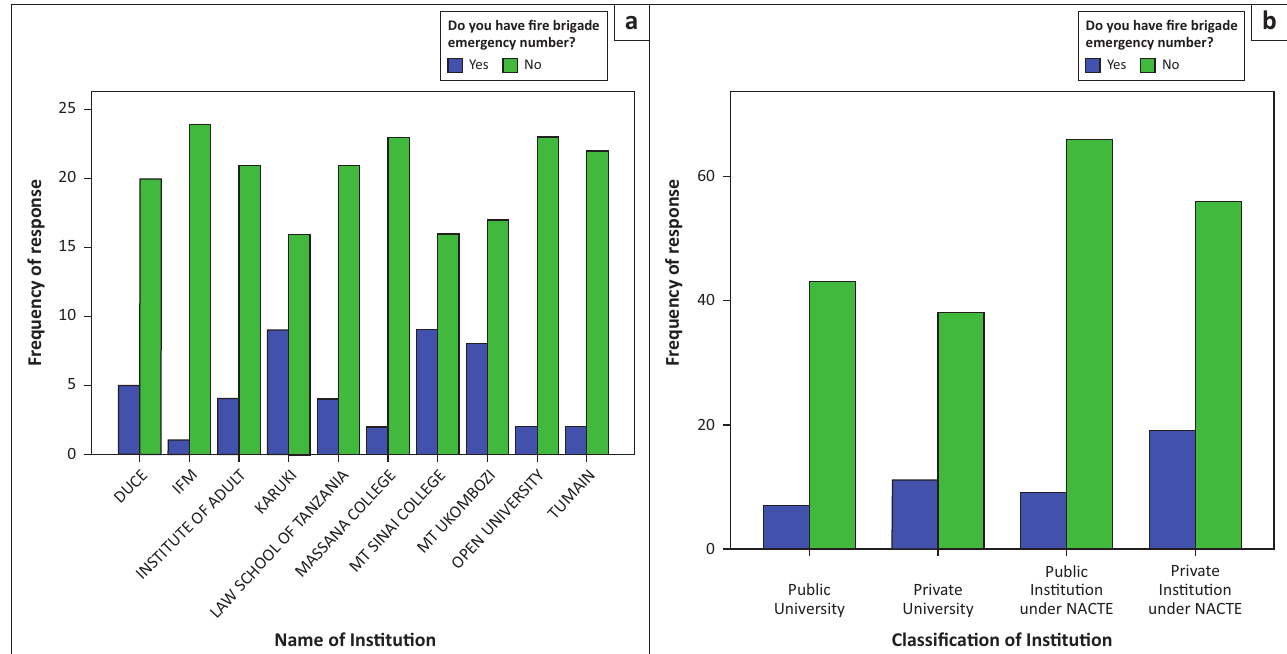
FIGURE 5: Knowledge on the fire brigade contacts. (a) Responses per institution and (b) responses per institution